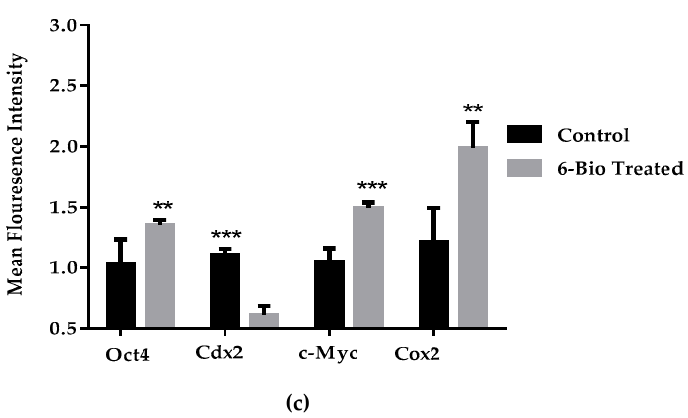
Figure 2. Wnt role in pluripotency and lineage specification during bovine BL development. (a-b) Representative images of pluripotency and lineage specific markers in control and 6-Bio (400 nM) treated group. DAPI labeled nuclei in blue. (c) Bar graph data of mean fluorescence intensities presented as a means ± SEM from three independent sets of experiment, including n = 20 BLs per group in each replicate. ** p < 0.01; *** p < 0.001 indicates significant difference. Original magnification 100×.